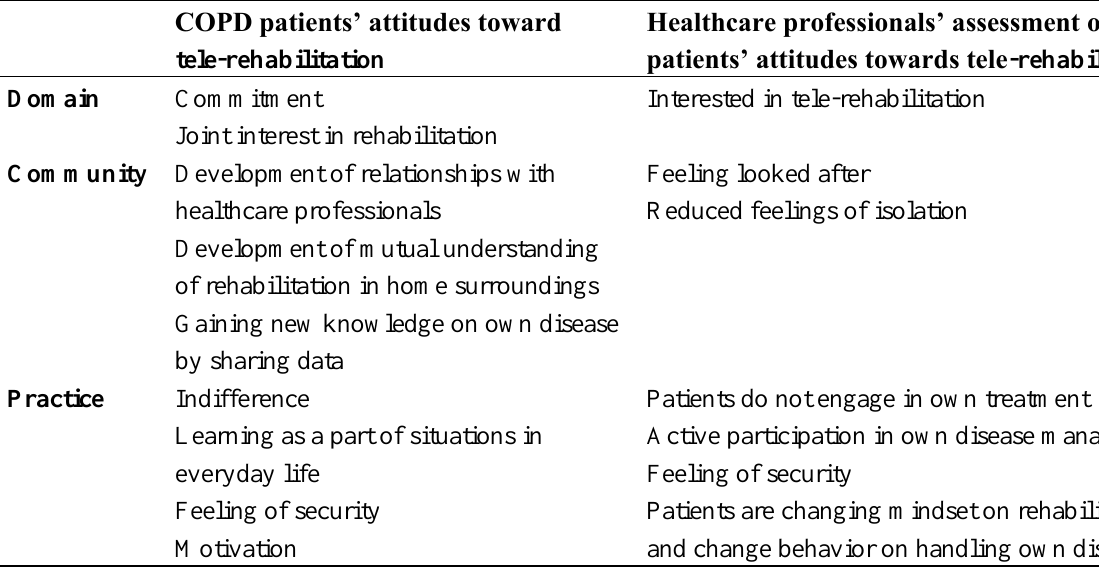
Table 4. Themes in COPD patients’ attitudes towards